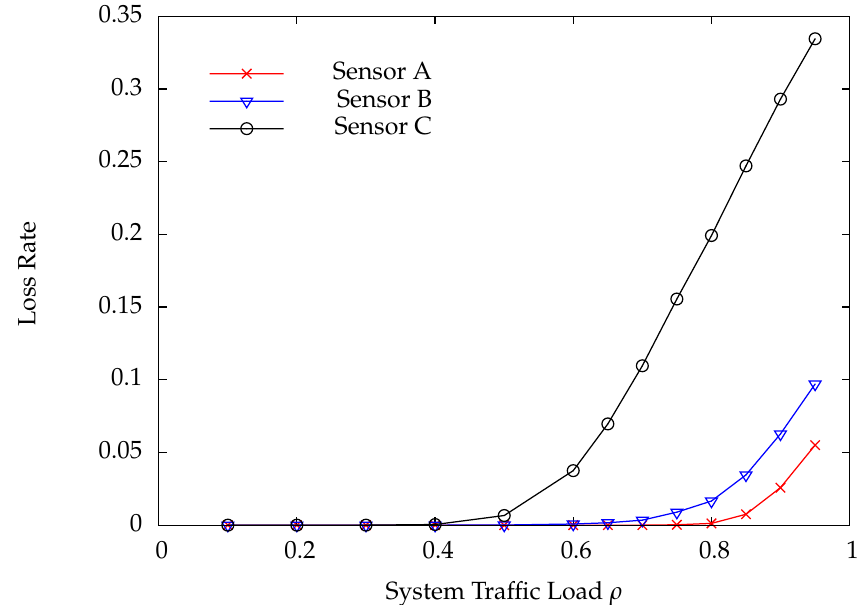
Figure 10. Loss rate versus system traffic load ρ